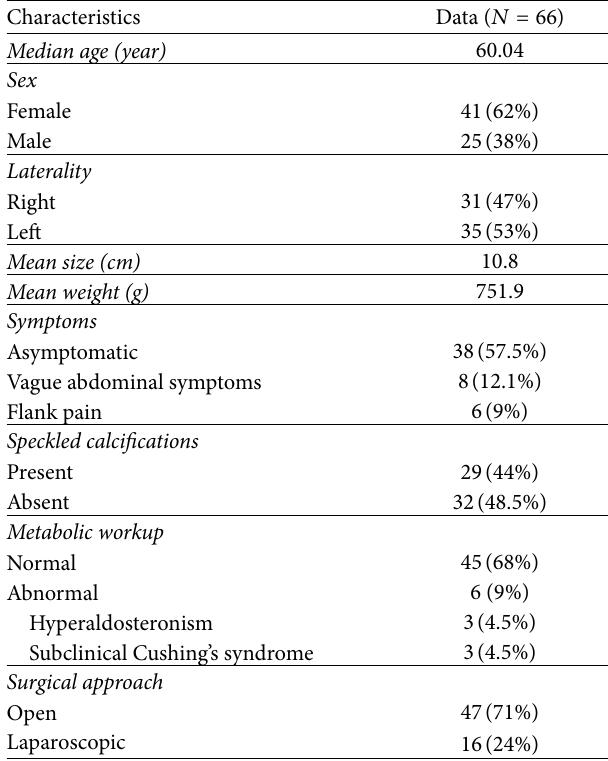
Table 2: Summary of characteristics of previously reported adrenal cavernous hemangioma in the